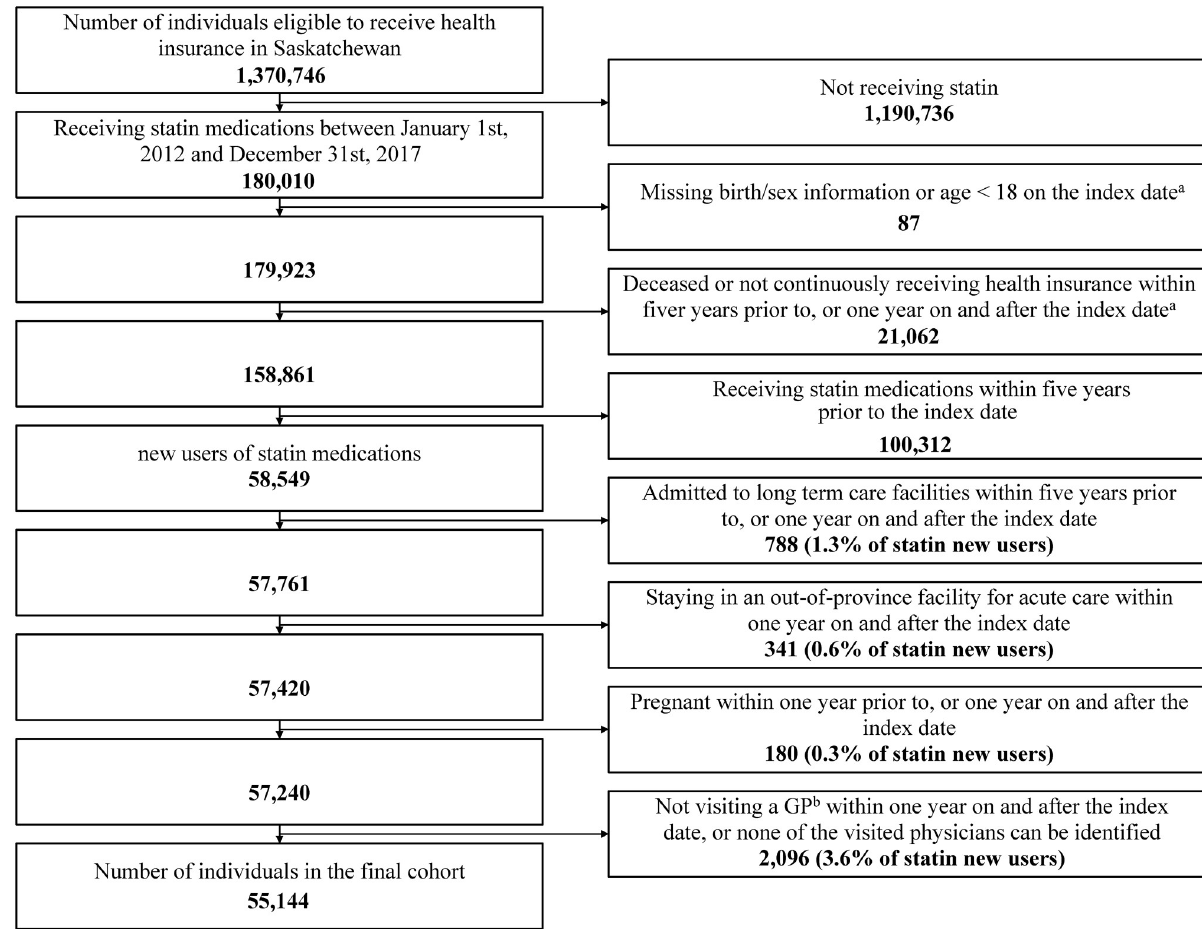
Fig 1. Cohort flow chart. a Index date = the earliest date receiving a statin medication between January 1st, 2012 and December 31st, 2017; b GP = general practitioner.